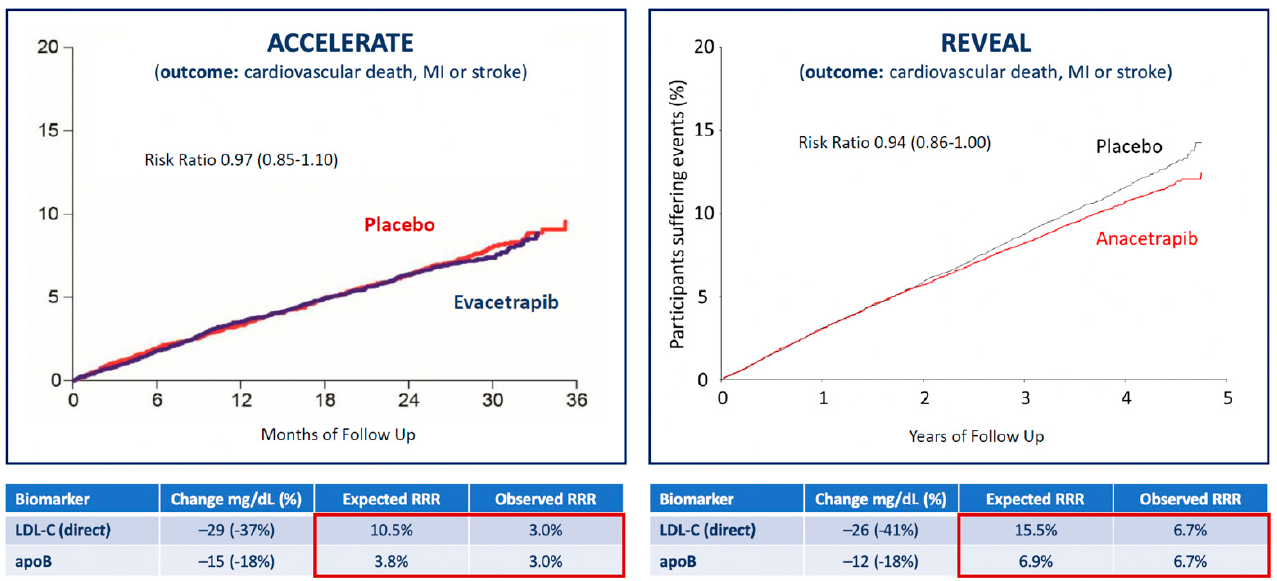
Figure 1. Reduction in risk of coronary or cardiovascular events per unit change in apoB in the cardiovascular outcome trials of evacetrapib and anacetrapib. Red boxes mark the expected and observed RRR associated with LDL-C and apoB changes in each trial. Abbreviations: apo, apolipoprotein; ACCELERATE, Assessment of Clinical Effects of Cholesteryl Ester Transfer Protein Inhibition with Evacetrapib in Patients at a High Risk for Vascular Outcomes; LDL-C, low-density lipoprotein cholesterol; MI, myocardial infarction; REVEAL, Randomized Evaluation of the Effects of Anacetrapib through Lipid-modification; RRR, relative risk reduction.